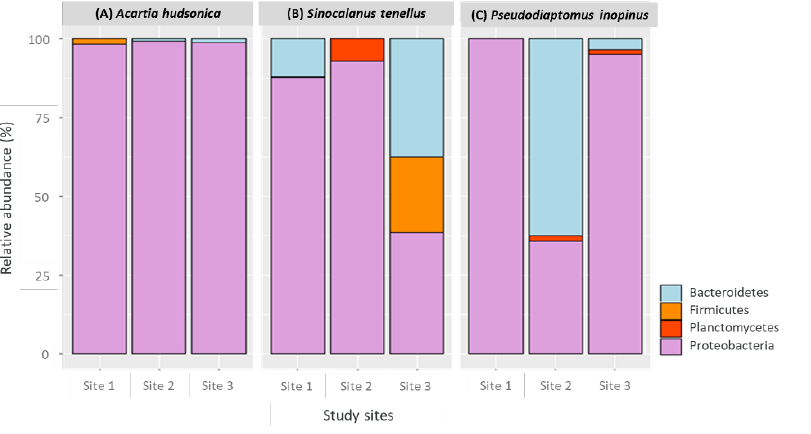
Figure 3. Relative operational taxonomic unit (OTU) abundance of copepod gut bacterial communities (%) based on phyla—( A ) Acartia hudsonica , ( B ) Sinocalanus tenellus , and ( C ) Pseudodiaptomus inopinus.